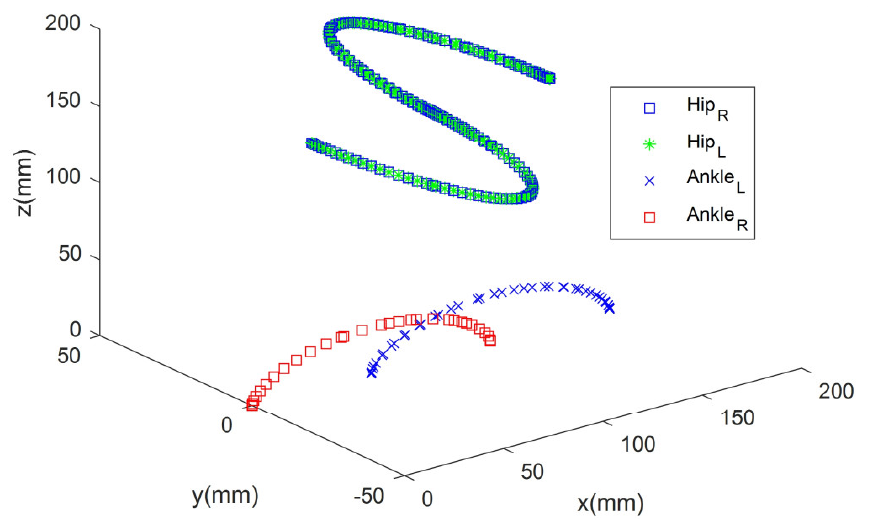
Figure 18. Three-dimensional representation of the walking model. When Figure 18 is examined, the robot’s speed is 60 mm/s in the x-axis, and the robot’s hip performs a swinging movement of a maximum of 50 mm. In addition, while walking, the robot’s foot rises a maximum of 30 mm from the ground. The ankle and hip joint trajectories for the right and left legs, along with their phases, are shown in Figure 19. The position coordinates of the hip joint relative to the ankle joint p , p , and p were calculated for both legs by the walking trajectory. The calculation x y z process consists of subtracting the ankle joint’s position from the hip joint’s position at each time step. Although there was no disturbance on the ground, the results of straight walking were closed loop. The gain coefficients K p , K i , and K d obtained by trial and error for the PID controller for body posture balancing were determined as 0.8, 7.1, and 0.01, respectively. According to Figure 19a, although the hip trajectory in the x-axis is the same for the right and left legs, it has mirrored oscillations for the ankle. According to Figure 19b, the ankle and hip trajectories are the same for both legs. According to Figure 19c, although the hip trajectory is the same for the right and left legs, the ankle trajectory